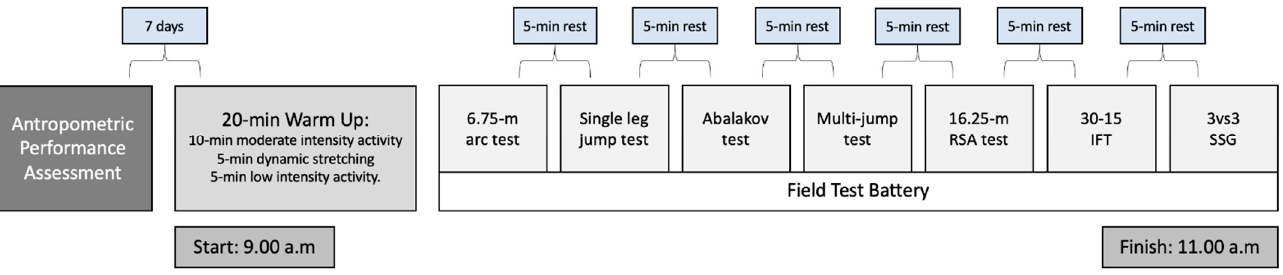
Figure 1. Experimental design of the present study.